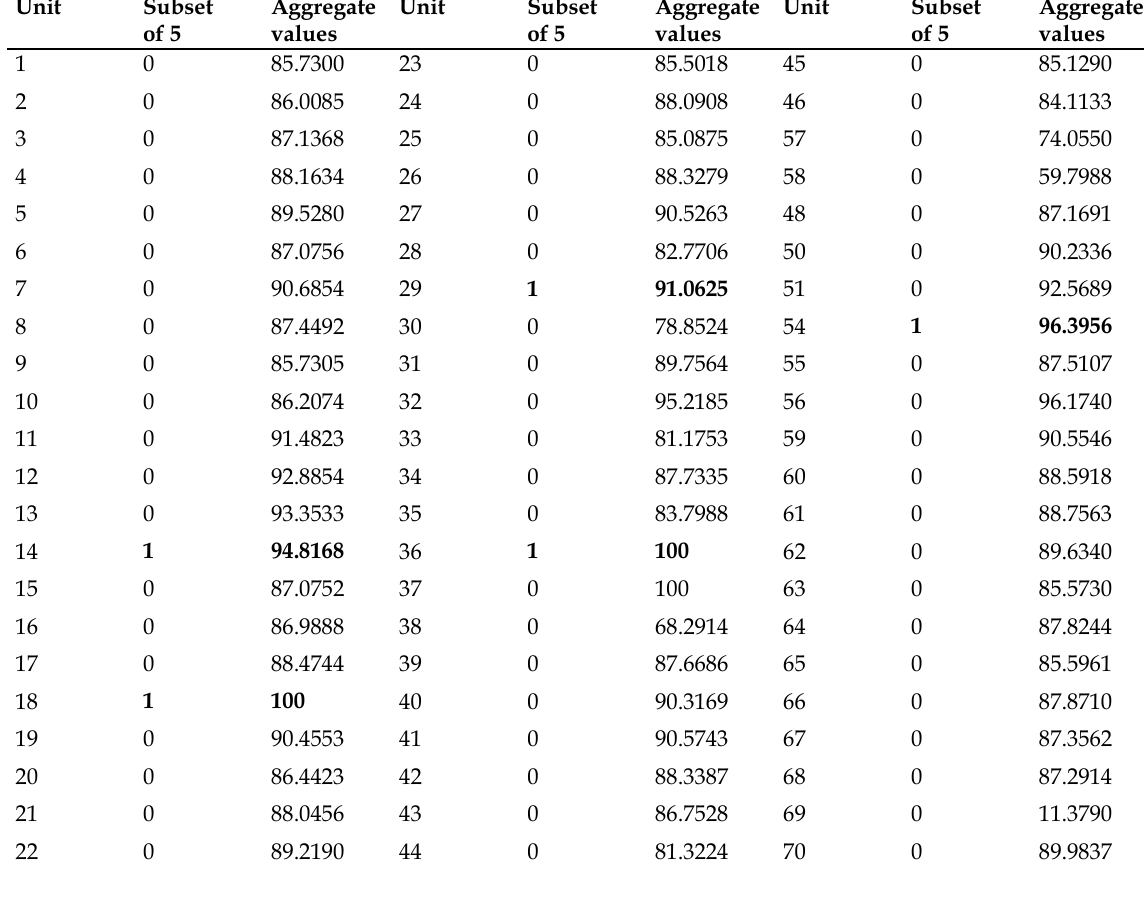
Table 3. Aggregate values of the 5-unit